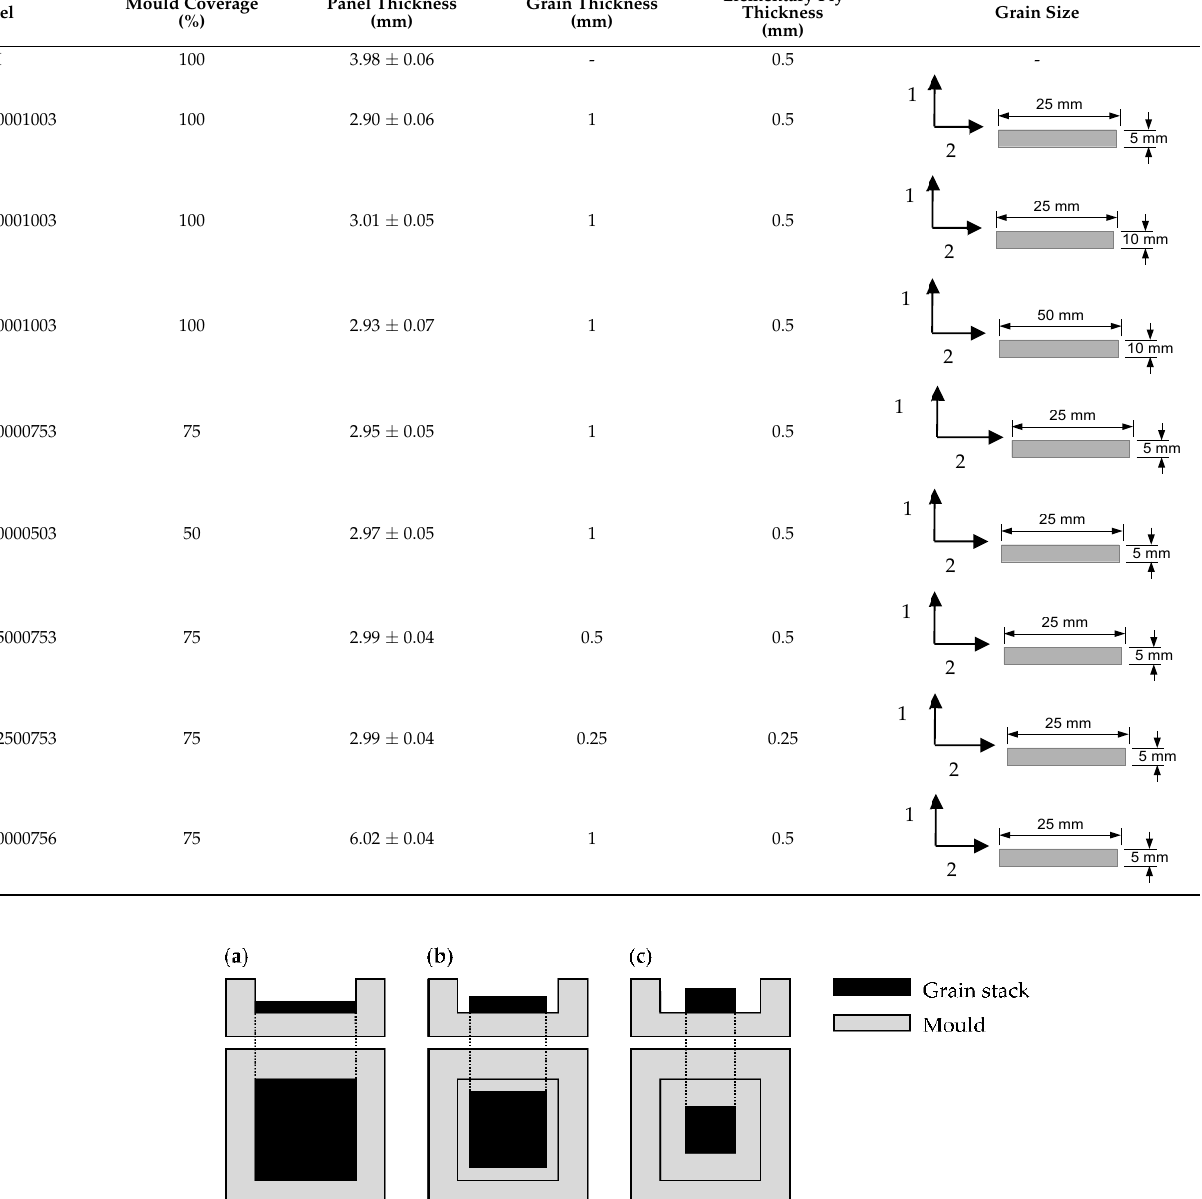
Figure 2. Illustration of mould coverage pattern and level ( a ) 100%, ( b ) 75% and ( c ) 50% .